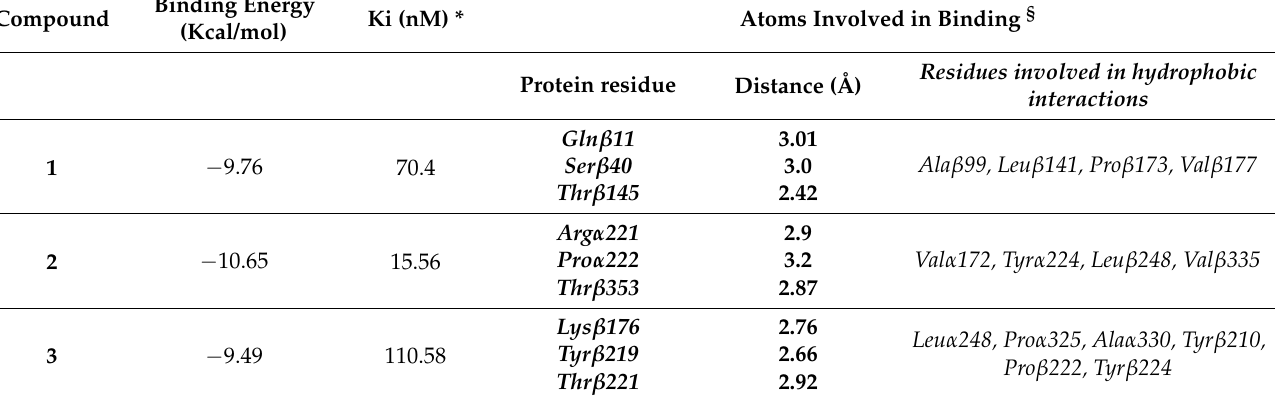
Table 2. Energies of the complexes formed by tubulin and compounds 1 , 2 , and 3 , and protein residues interacting with the ligands.